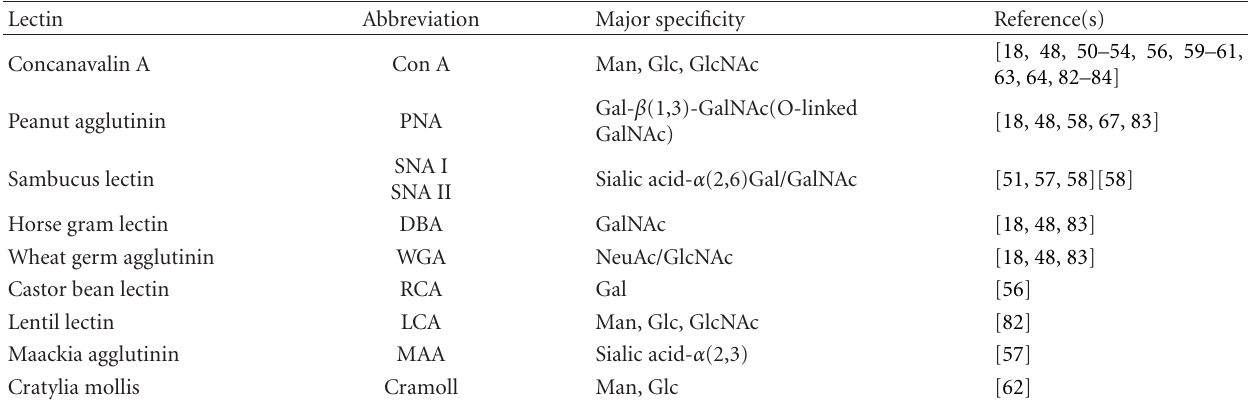
Table 1: Lectins used in glycobiosensor applications noted within this